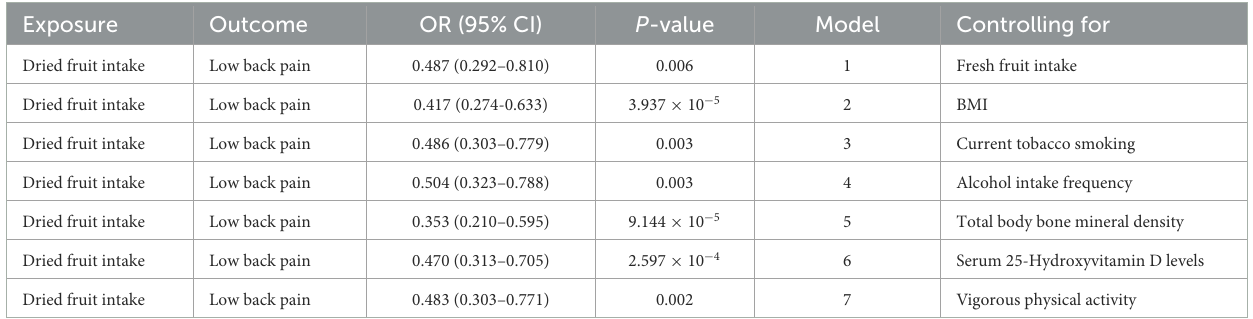
TABLE 4 Results of multivariable